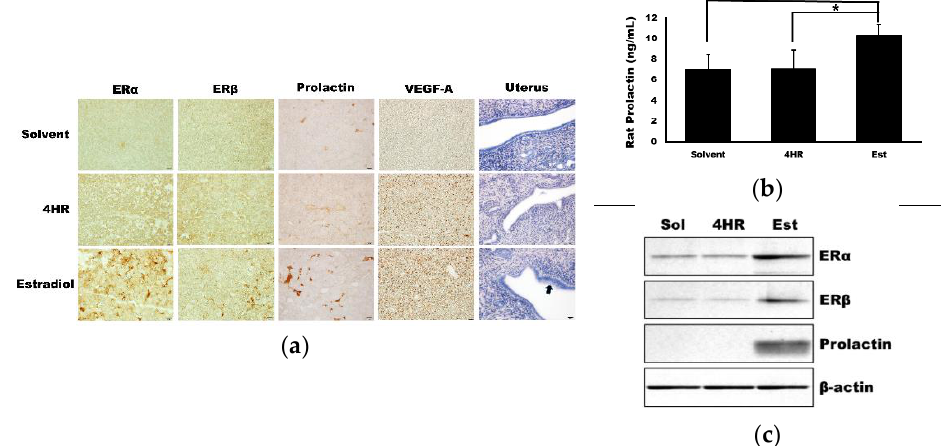
Figure 4. The results of in vivo experiment. ( a ) Daily application of 1 µ g / kg for 17- β -estradiol in the ovariectomized rats resulted in increased prolactin, ER α , and ER β expression level in the pituitary gland. However, daily application of 128 mg / kg for 4HR and solvent only groups showed low levels of prolactin, ER α , and ER β expression in the pituitary gland. Interestingly, both 17- β -estradiol group and 4HR group showed high levels of vascular endothelial growth factor (VEGF)-A expression in the pituitary gland. In addition, epithelial hyperplasia was only observed in the estradiol group (arrow) (bar = 20 µ m). ( b ) Blood prolactin level. Blood prolactin levels were increased in the estradiol group compared to the 4HR and solvent only groups (* p < 0.05). ( c ) Western blot for pituitary gland tissue samples. Prolactin, ER α , and ER β expression were increased in the estradiol group (Sol: solvent only group; Est: estradiol group). Full length blots were available in Supplementary Figure